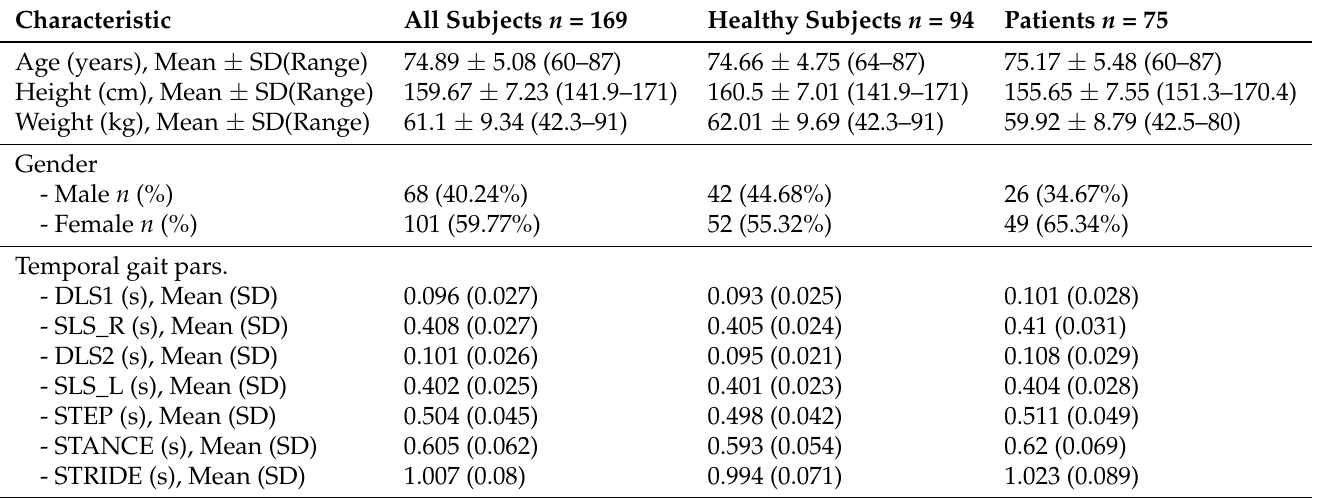
Table 1. Demographic information of the subjects.